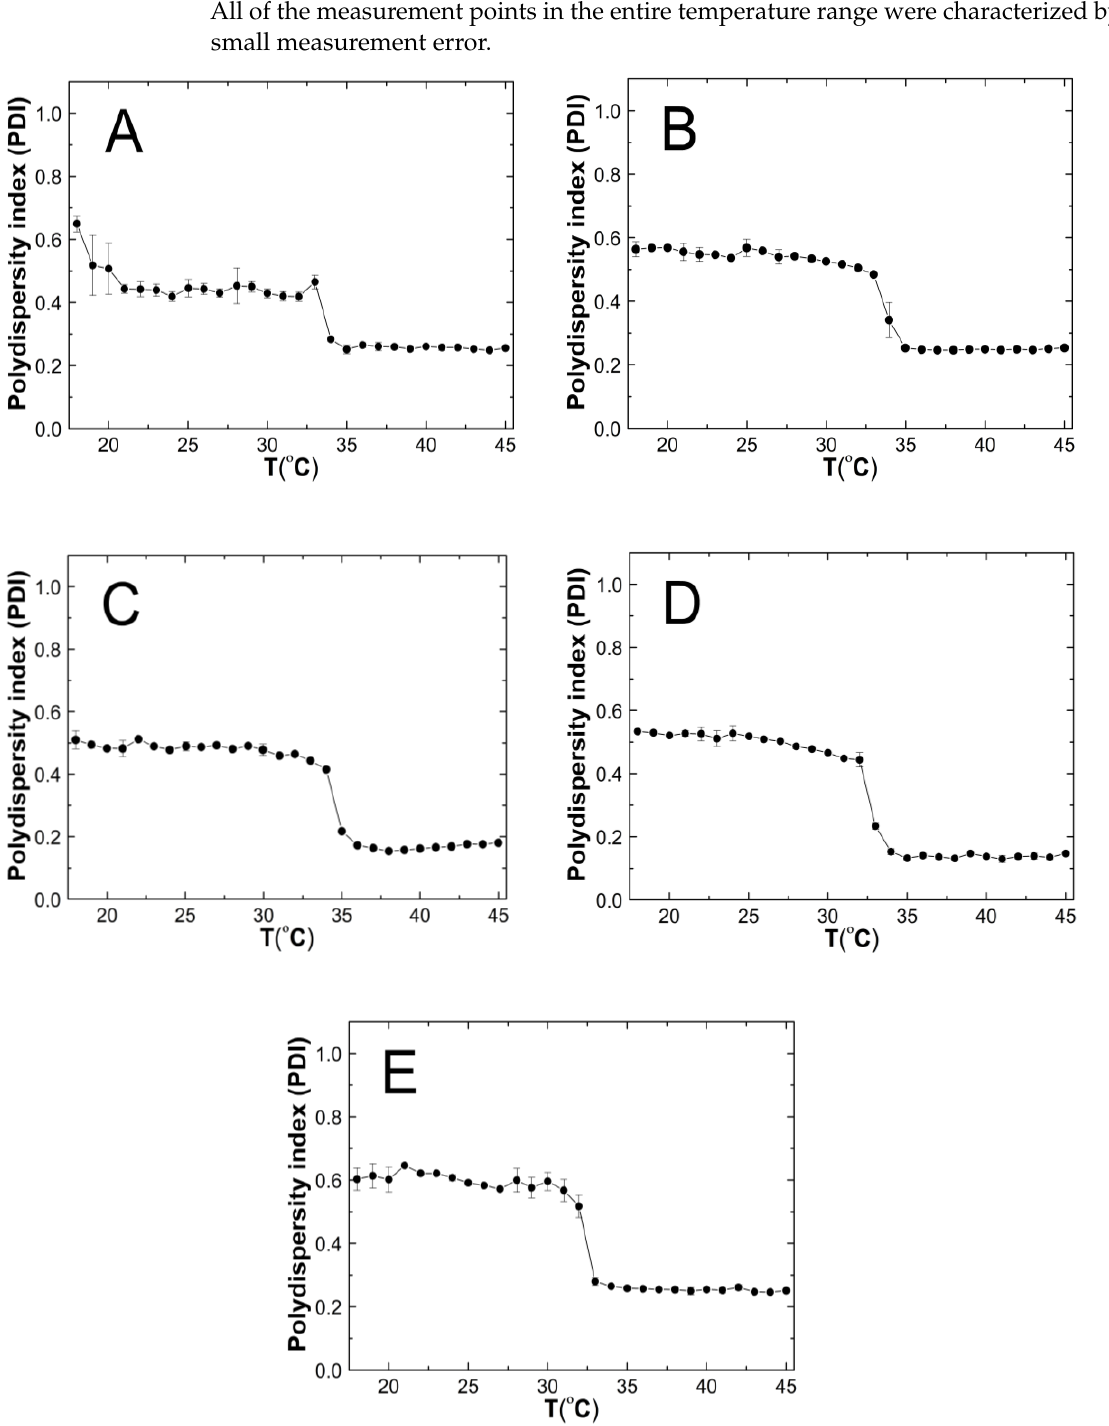
Figure 9. The influence of temperature on the polydispersity index (PDI) of P1 ( A ), P2 ( B ), P3 ( C ), P4 ( D ), and P5 ( E ) samples as determined by dynamic light scattering.